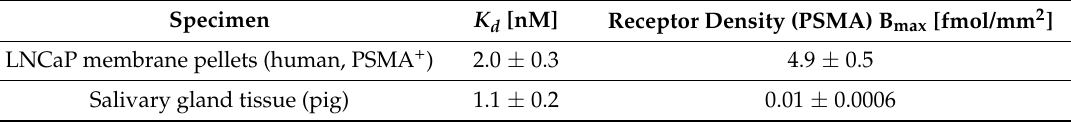
Table 1. Binding affinity of [ 177 Lu]Lu-PSMA-617 and receptor density of PSMA on LNCaP membrane pellets and pig salivary gland tissue.